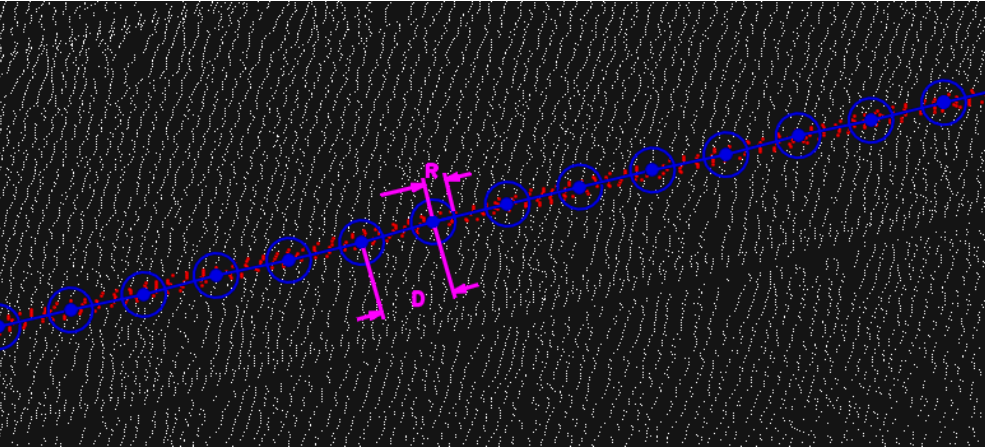
Figure 5. Three-dimensional line creation schema based on the classified 0 scan angle value points ( red ). Each new line vertex coordinates result from the average point coordinates inside each R-ray circle, with D as the approximate distance between vertices.